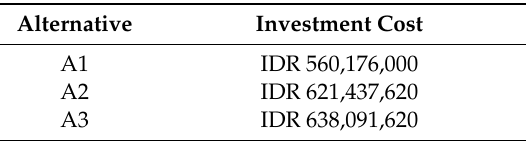
Table 5. Total Table 5. Total investment.